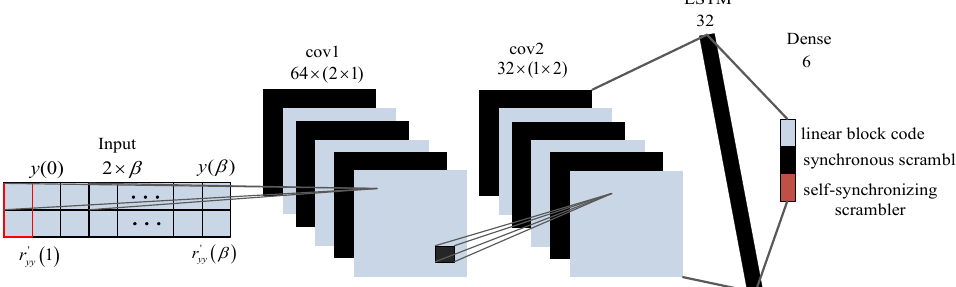
Figure 6. Correlation feature extraction network model diagram .